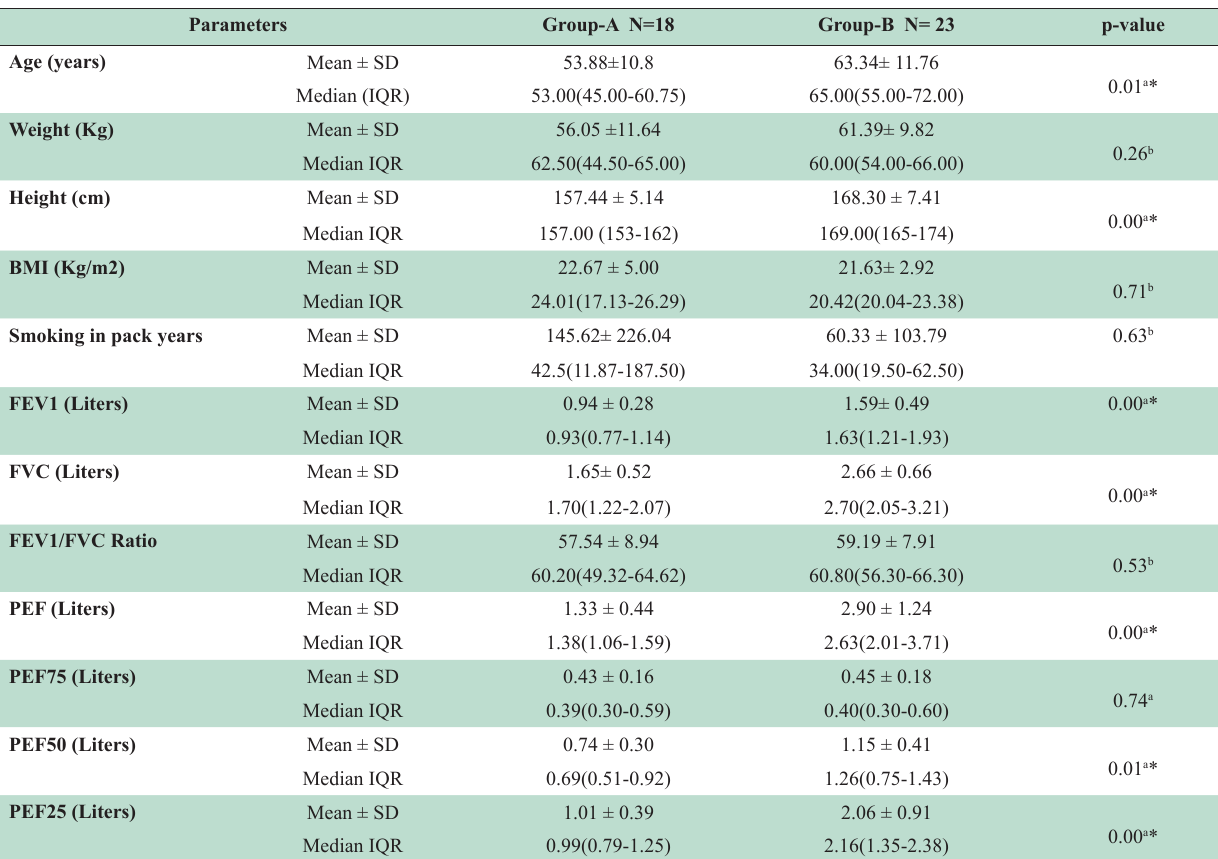
Table-I: Comparison of demographic and spirometry parameters between Group-A (Female smokers with COPD) and Group-B (Male smokers with